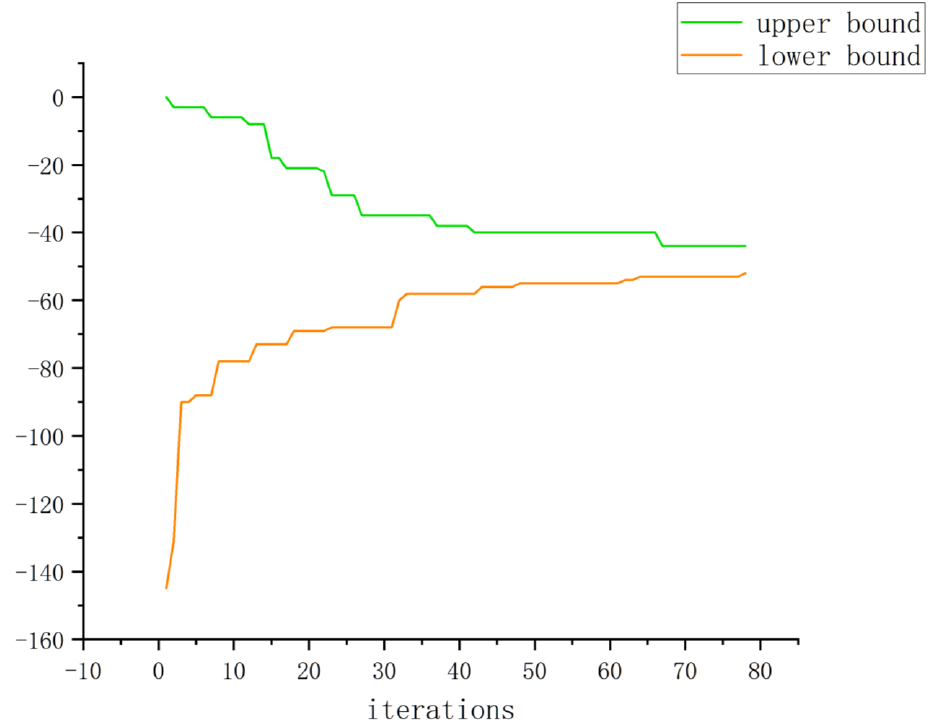
Figure 7. Upper and lower bounds of the objective function value of scenario 2.